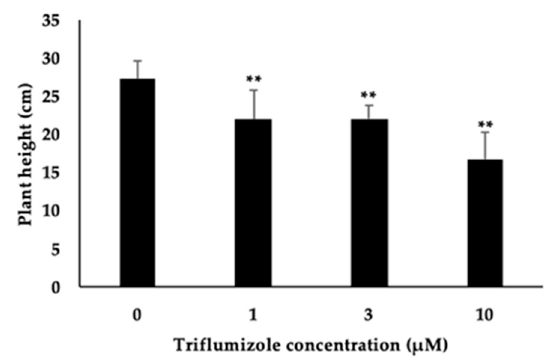
Figure 5. Plant height of 23-day-old rice seedling supplemented with 1, 3, or 10 μ M triflumizole for two weeks. The data are expressed as mean ± SD ( n = 10). ** denotes statistically significant difference from the plant height of non-treated triflumizole ( t test; p < 0.01).